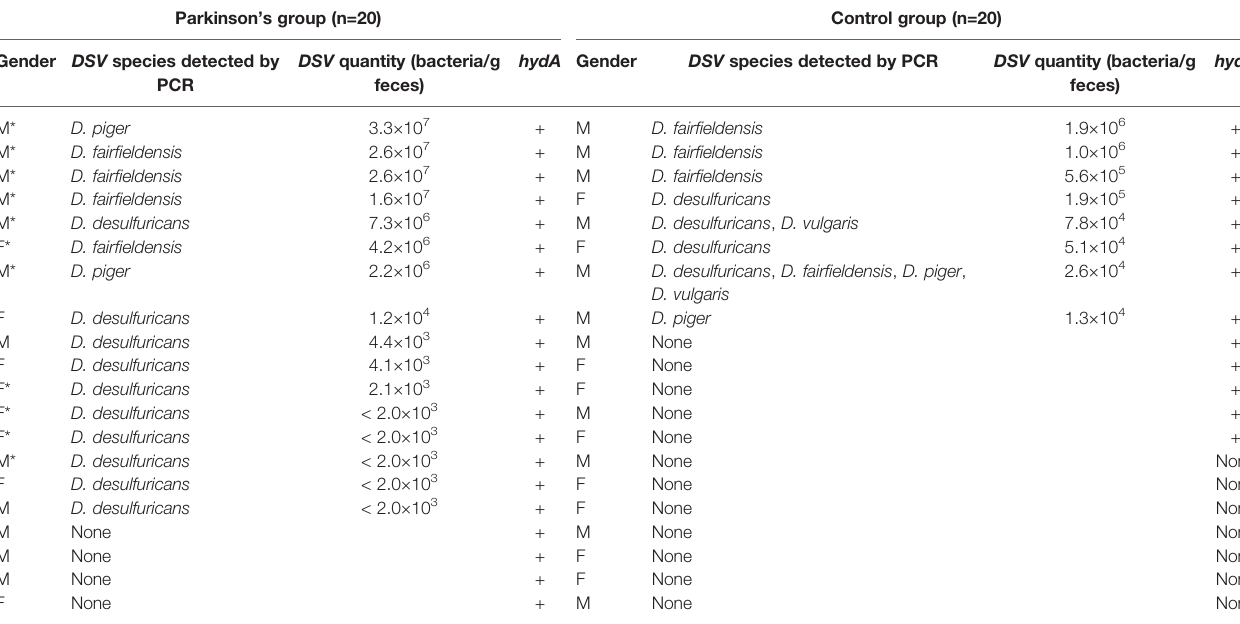
TABLE 3 | Summary of the PCR detection and quanti fi cation of Desulfovibrio spp. from patients and healthy individuals. Parkinson ’ s group